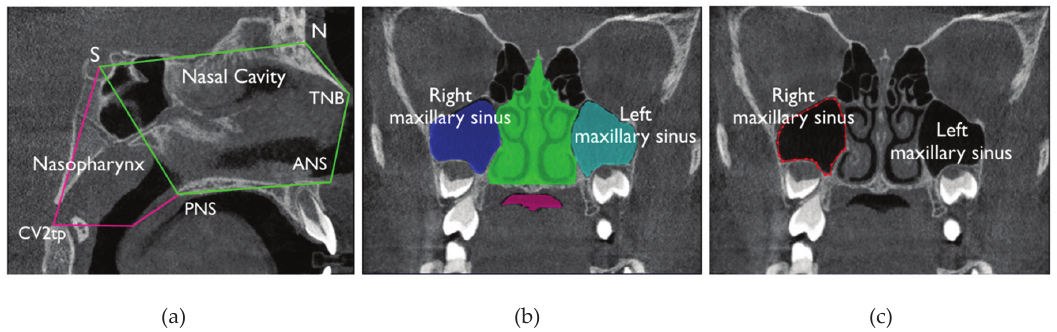
Figure 1. Visual explanation of planes and points used on the different cone-beam computed tomography (CBCT) axis for ITK-SNAP to perform volume segmentation of the respiratory segments analyzed: Nasal cavity, maxillary sinuses, and rhynopharynx. ( a ) sagittal view; ( b , c ) coronal views.